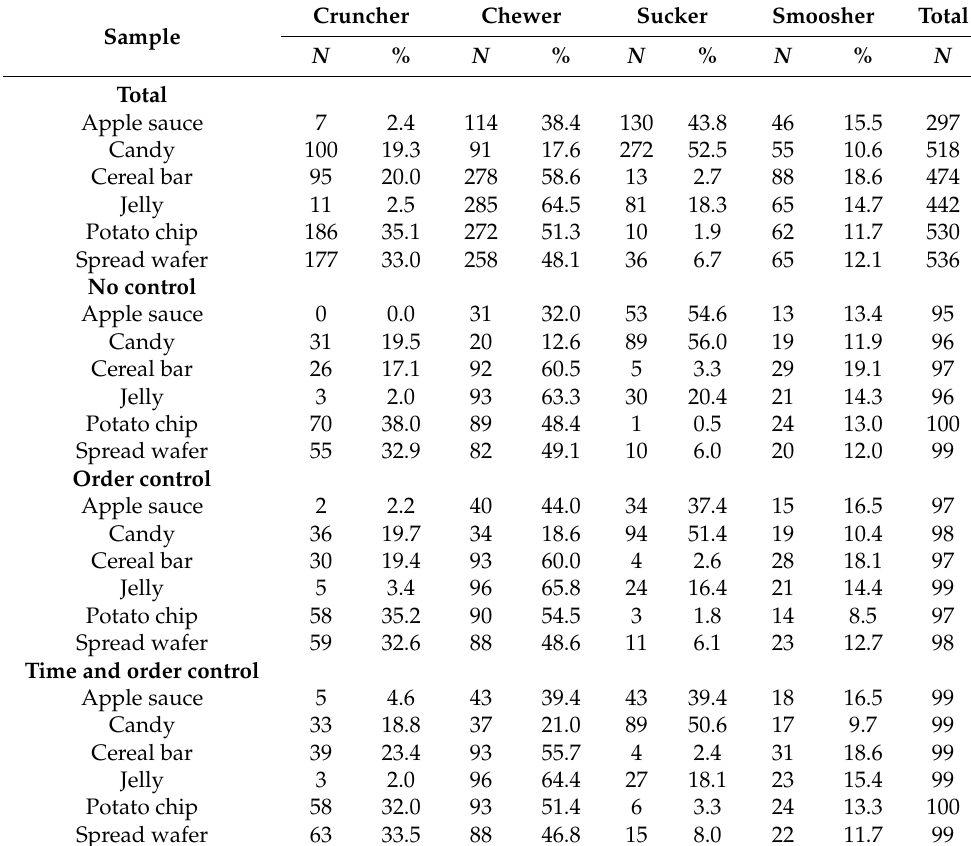
Table 10. Mouth behavior of the consumers used during